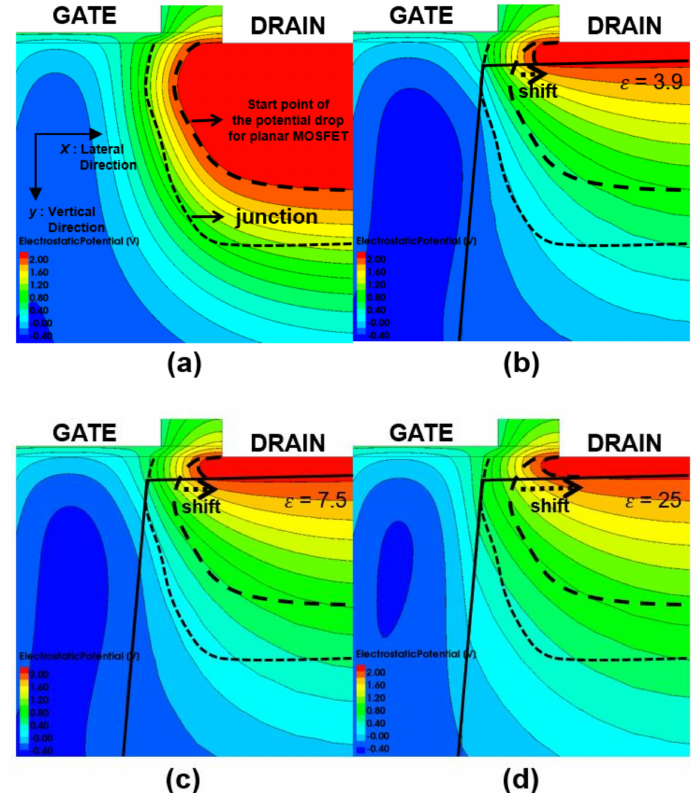
Figure 4. Two-dimensional potential contour profiles (at V GS = 0.0 V, V DS = 1.6 V) of 0.2 steps near the drain region in ( a ) planar MOSFET, ( b – d ) PiFETs with slope 5 and silicon film thickness of 15 nm. ( b ) k = 3.9, ( c ) k = 7.5, ( d ) k =